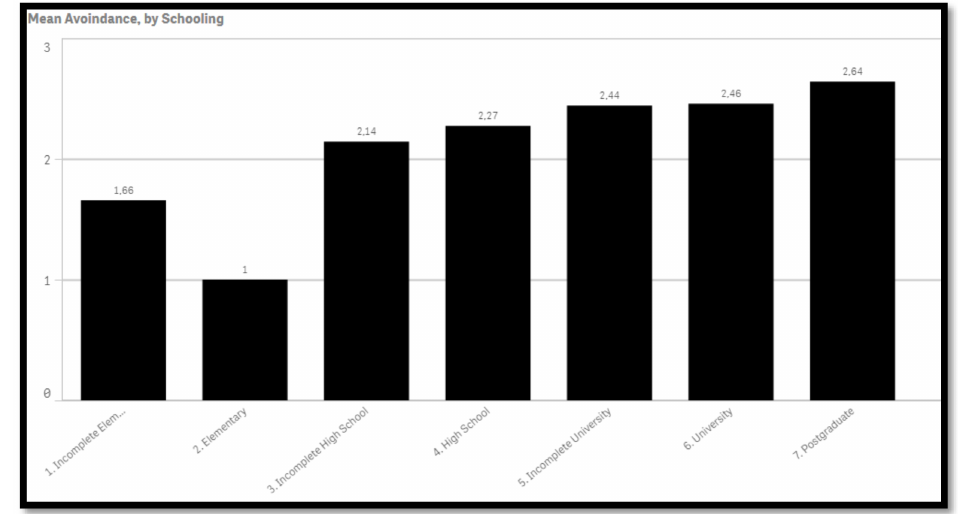
Figure 6. Avoidance, by Schooling. Source: data study